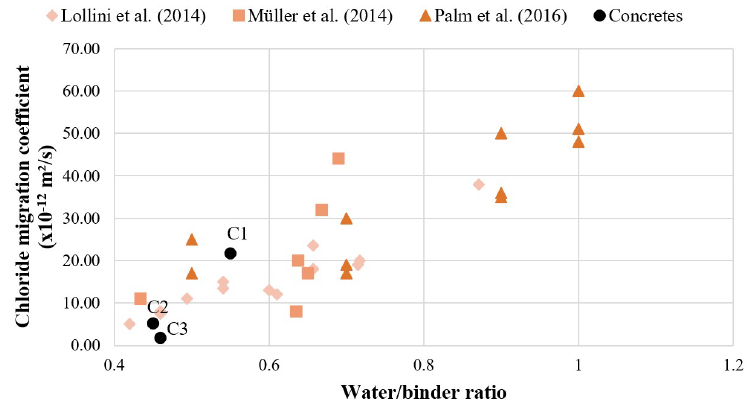
Figure 7. Chloride migration coefficient versus water/binder